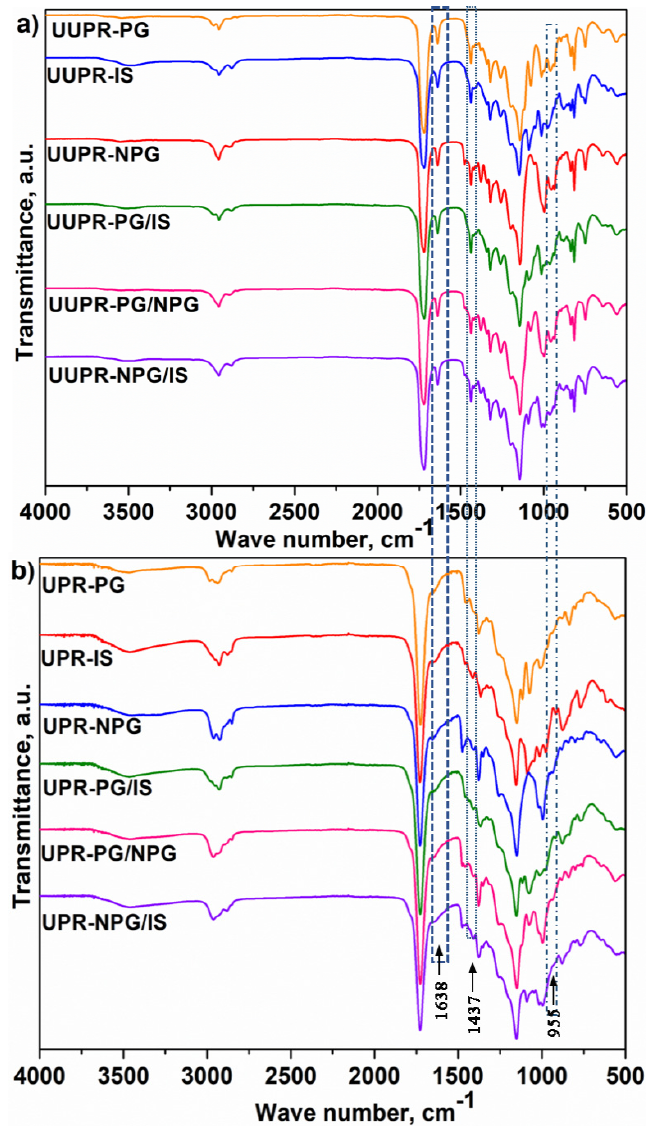
Figure 1. FTIR spectra of: ( a ) the uncured and ( b ) cured samples.